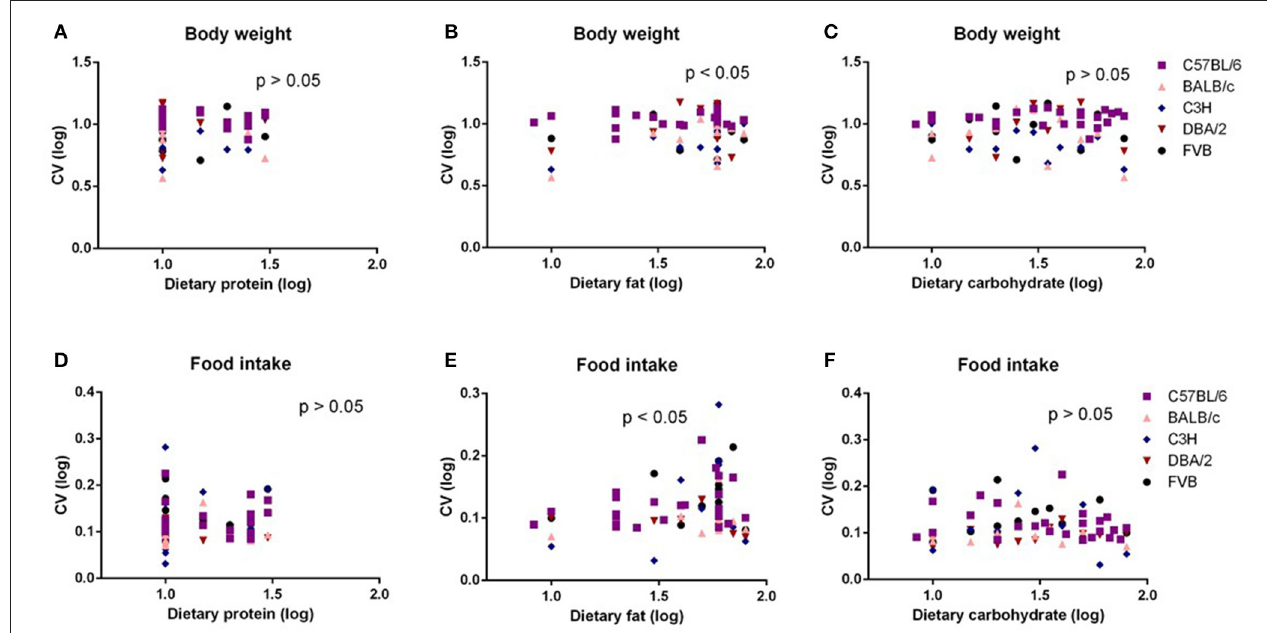
FIGURE 1 | The diagram showing the relationship between dietary macronutrient content and the coefficient of variation (CV) of body weight and food intake. The correlations between logged dietary fat, protein, and carbohydrate contents and (A–C) logged CV of body weight and (D–F) food intake of the last week (10th week) at different diet treatment periods, respectively ( n =